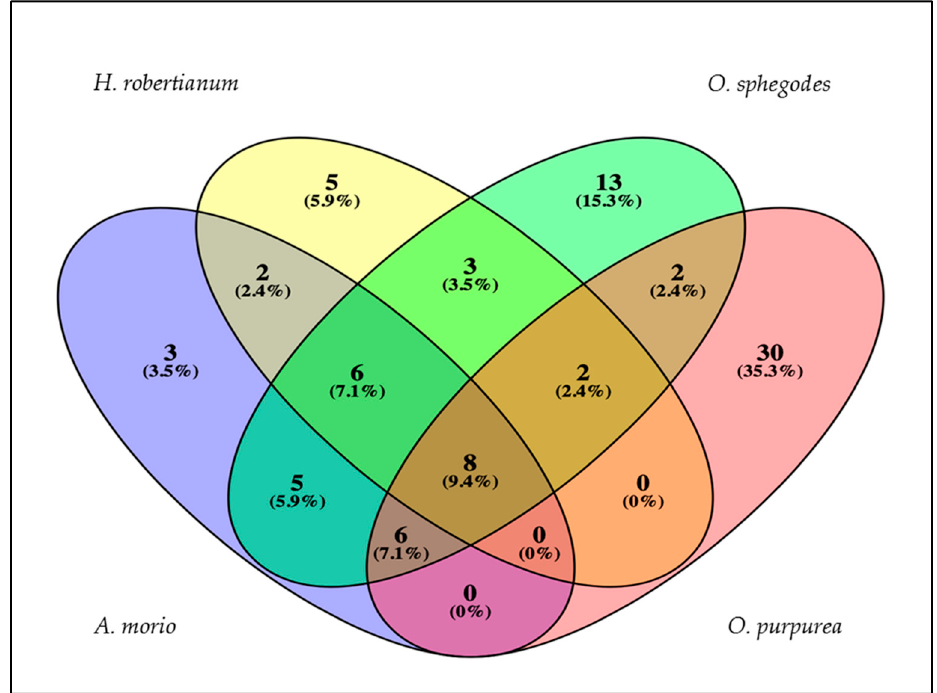
Figure 3. Venn’s diagram shows both the number of compounds shared and unshared/peculiar among the four orchid species. Percentages are referred to the total number of compounds found, not to the relative